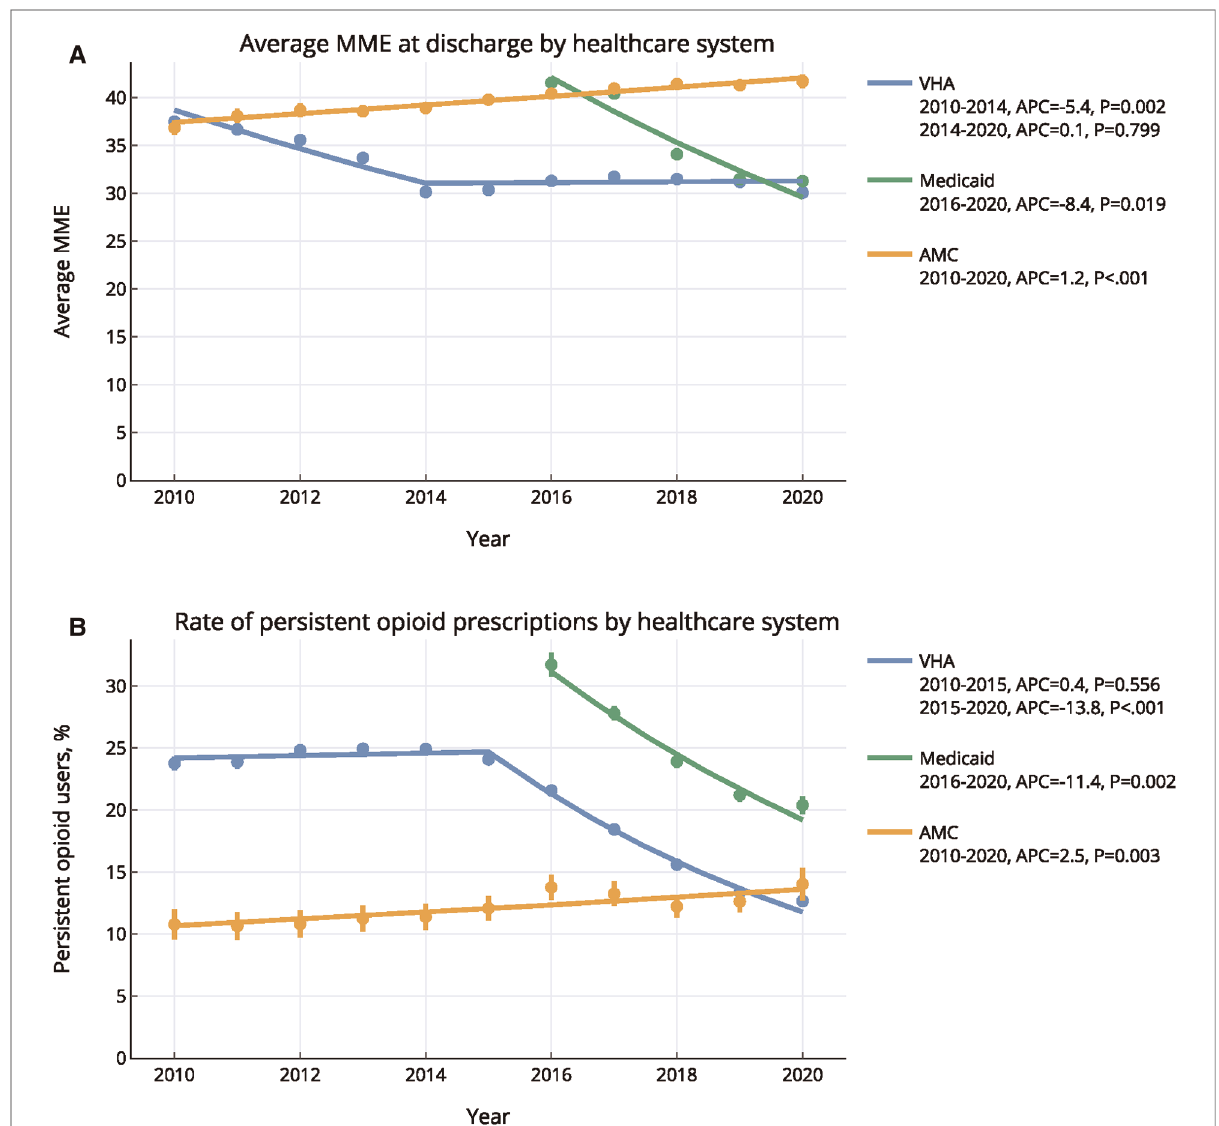
FIGURE 2 Annual trends of ( A ) opioid prescribing and ( B ) persistent opioid prescriptions in three healthcare systems, 2010 – 2020 *error bars indicate 95% con fi dence intervals. Trends were calculated using the ioinpoint regression algorithm. VHA, veterans health administration; AMC, academic medical center; MME, morphine milligram